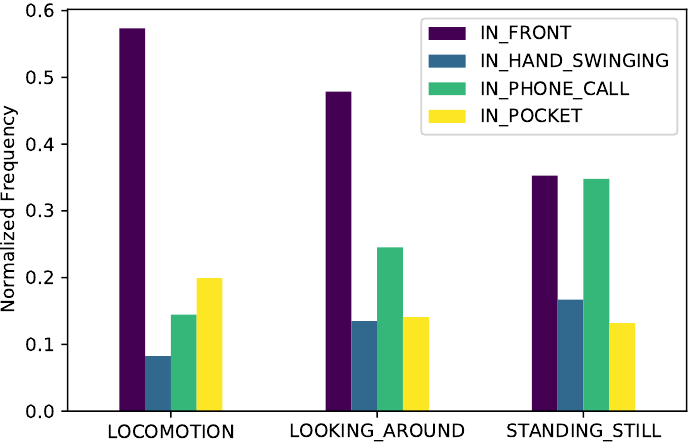
Figure 14. Normalized frequency of each device placement during the main